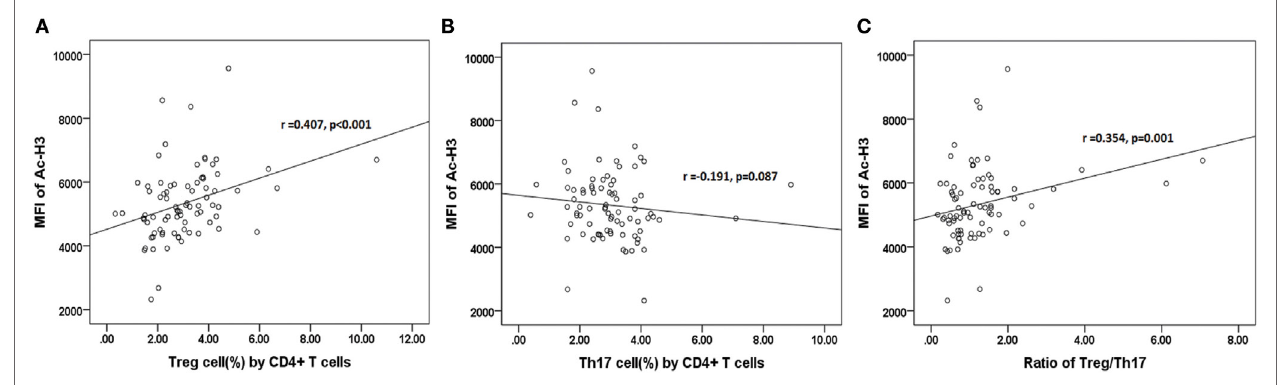
FigUre 8 | Correlations between acetylated histone H3 and percentages of Treg (a) or Th17 (B) cells, or the Treg/Th17 ratio (c)